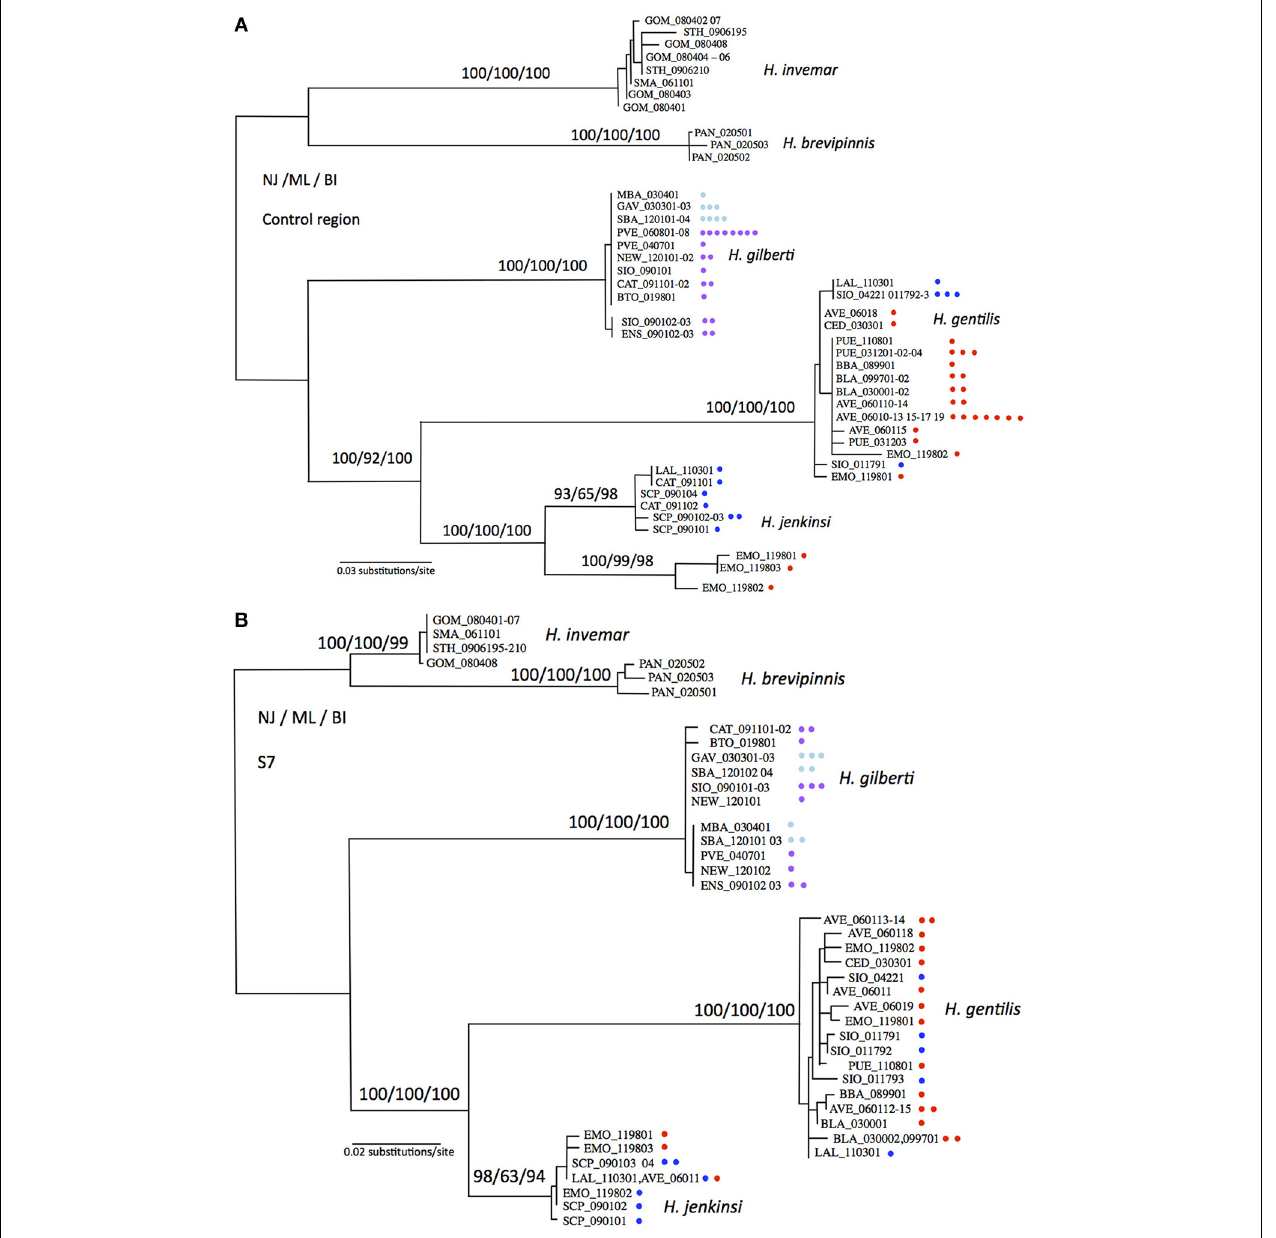
FIGURE 2 | Maximum likelihood phylogenetic reconstructions for Hypsoblennius spp. Support for major nodes is given in percent bootstrap or posterior probability for Neighbor Joining, Maximum Likelihood and Bayesian Inference above the nodes (NJ/ML/BI). One branch is shown per haplotype, each individual is indicated by a dot, as to show the total number of individuals sequenced. Phylogenetic trees are